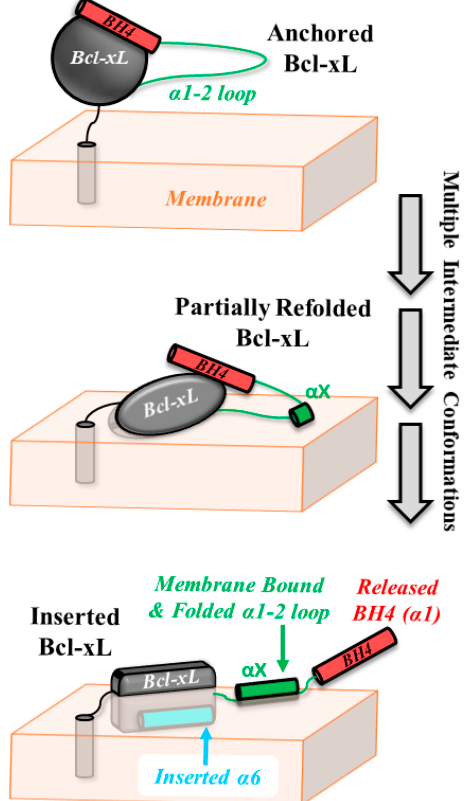
Figure 7. Schematic representation of the conformational switching pathway between membrane-anchored and inserted Bcl-xL. After the initial targeting to the MOM via a yet to be fully understood mechanism, Bcl-xL resides in the conformation closely resembling its solution fold, anchored by a single transmembrane helix α 8 [16] (top panel). This anchored conformation is distinctly different from the membrane-inserted one (lower panel), characterized by the refolded secondary and tertiary structure, bilayer penetration of various segments (e.g., α 6 helix resides about 15 Å from bilayer center [13], and the release of the regulatory BH4 domain ( α 1 helix) [13]. In this study, we demonstrated that the originally disordered loop between helices α 1 and α 2 gained helical structure (helix α X) and interacted with the membrane (Figures 3 and 4). Our single-molecule FRET measurements indicated that the insertion transition contained several intermediate states of di ff erent compactness (Figure 6). Lipid composition (notably the presence of cardiolipin and other anionic lipids) modulates the propensity of Bcl-xL to undergo protonation-dependent insertion. We hypothesized that conformational switching between the anchored and the inserted conformations of Bcl-xL results in functional switching between canonical and non-canonical (BH4-dependent) modes of apoptotic inhibition (Figure 1b).